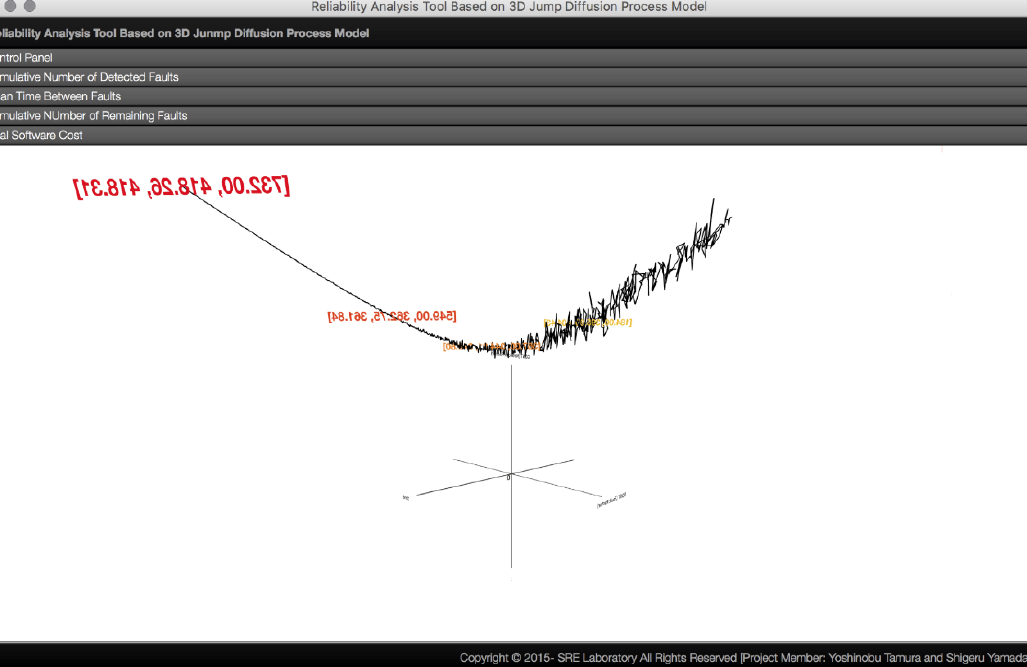
Fig. 5. Cost optimization